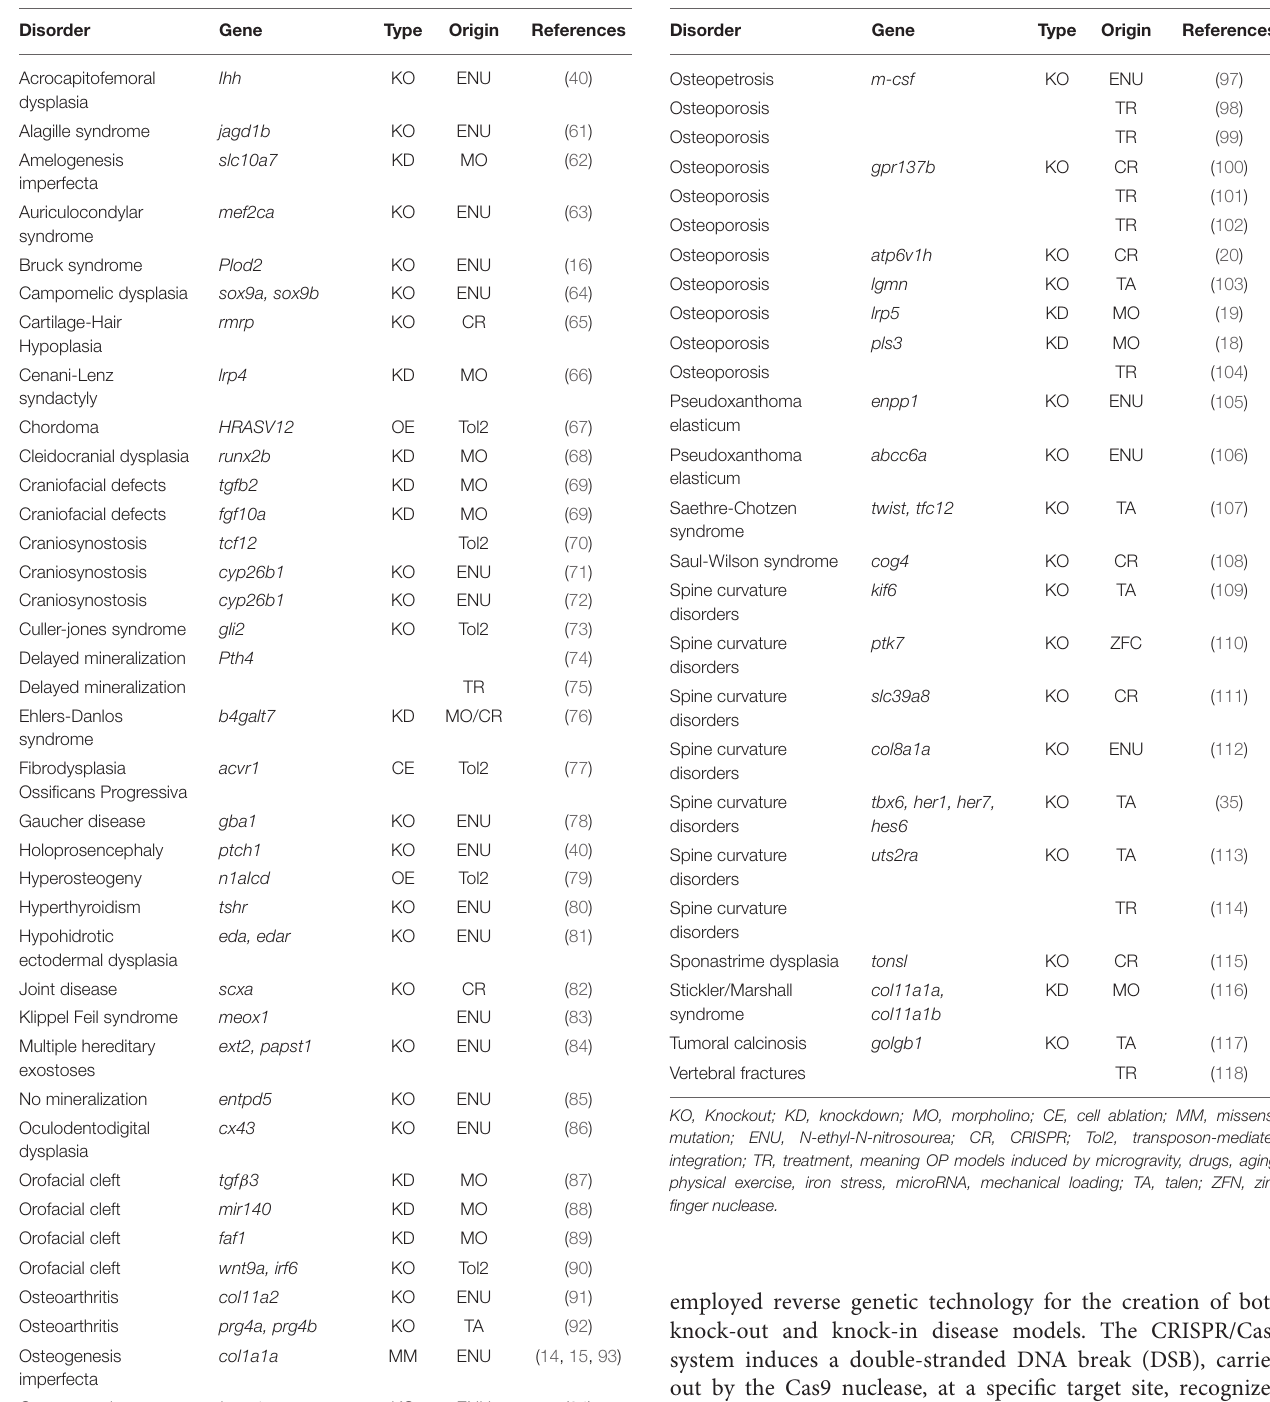
TABLE 1 | Zebrafish models for skeletal